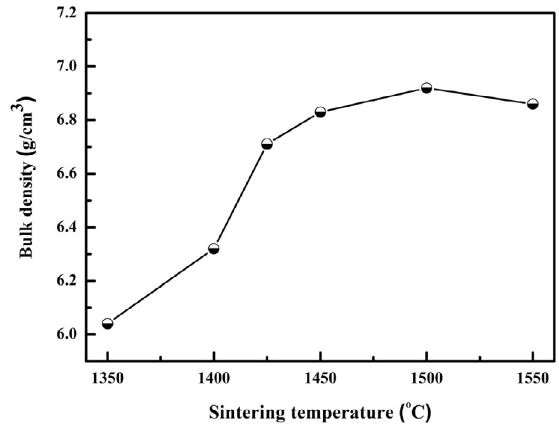
Fig. 7 Bulk densities of SmAlO 3 ceramics sintered at different